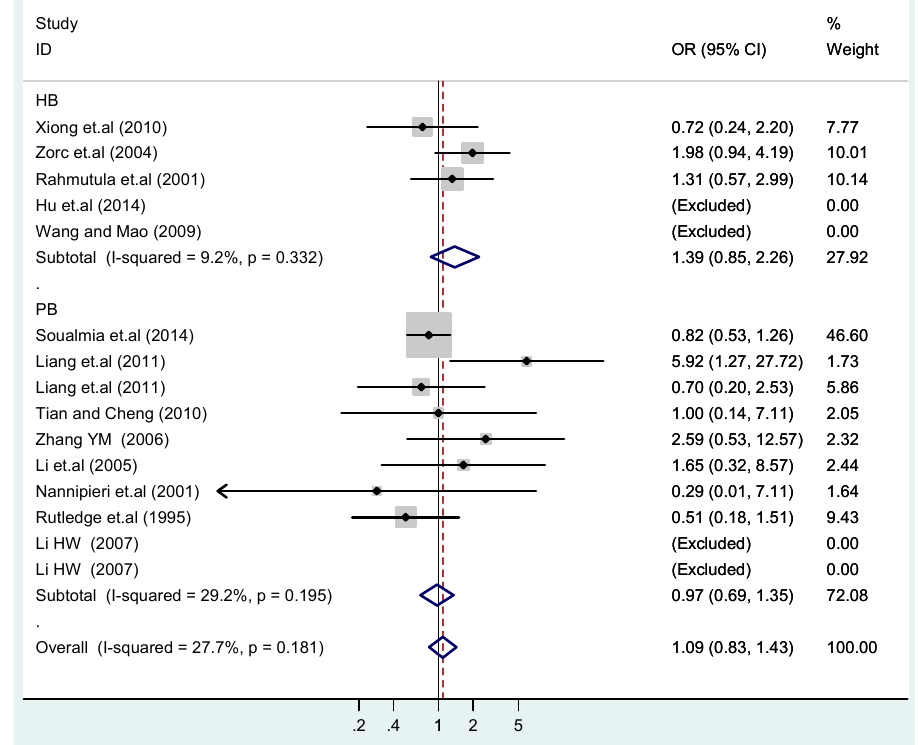
Figure 19. Subgroups of genotyping methods of T2238C additive model (C vs. T).